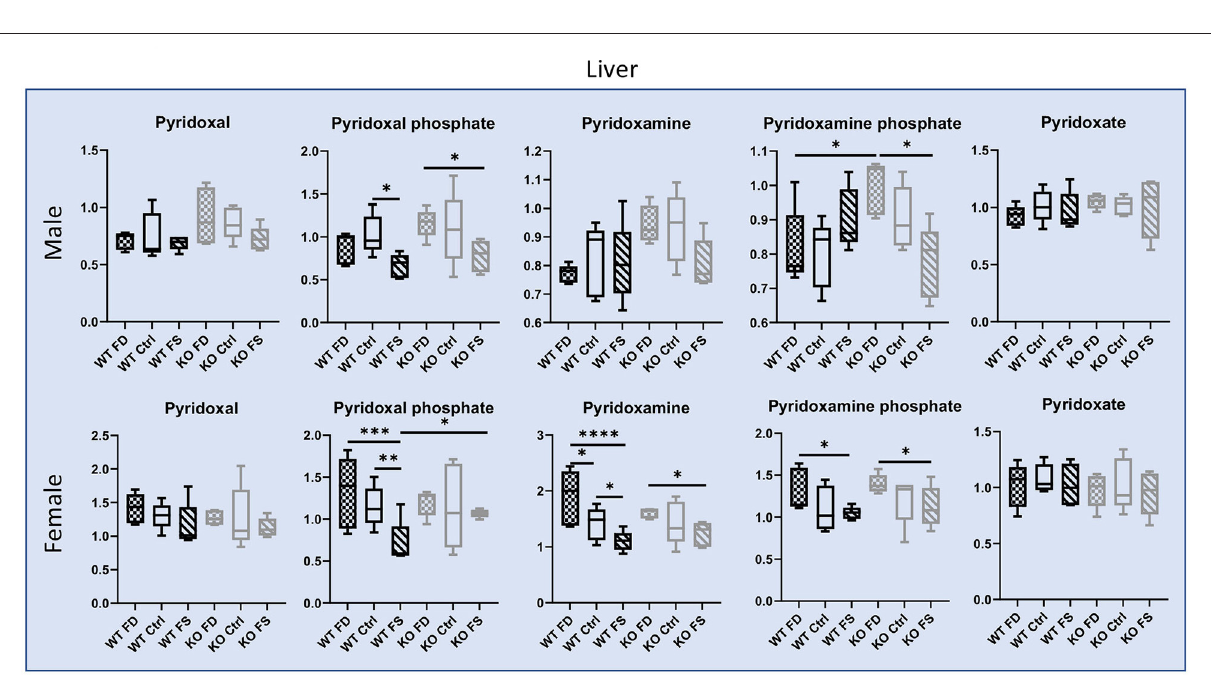
FIGURE 7 | Liver concentrations of B 6 vitamers and their phosphorylated forms are significantly higher in female vs. male livers, and dietary FA altered several vitamin forms, except the degradation product pyridoxate. Data show minimum and maximum, with bar at median value, n = 5. Checked bars, FD diet; solid bars, Ctrl diet; striped bars, FS diet. WT is shown in black, and KO is shown in gray. * p < 0.05; ** p < 0.01; *** p < 0.001; **** p < 0.0001; determined by ANOVA comparisons. at highest supplementation, also in the WT mice (0.61- to did not reach statistical significance. The degradation products 0.7-fold). The testes showed a tendency for ascorbate increase in males showed no differences between dietary groups, while in at highest FA dose, while other metabolites had no significant females, threonate increased at highest FA supplementation in changes ( Supplementary Figure 6 ; Supplementary Table 2 the WT mice (1.6- to 2.42-fold), while oxalate showed reduction